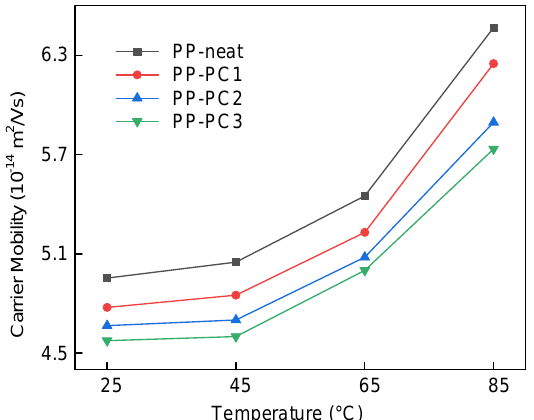
Figure 7. Relationship between the carrier mobility and the sample temperature. It also can be obtained that the carrier mobility of PP-PC1, PP-PC2, and PP-PC3 is lower than that of PP-neat. The decreased carrier mobility can be explained by the introduced DTLs by polycyclic compounds. It is hard for trapped charges to detrap from DTLs because the trapped charges need more energy to detrap from the DTLs. The PP-PC3 presents the lowest carrier mobility, which is related to the deepest DTLs of PP-PC3. The decreased carrier mobility leads to the lower DC conductivity of PP-PC1, PP-PC2, and PP- PC3, as shown in Figure 3. The lowest carrier mobility explains the mechanism of the lowest DC conductivity of PP-PC3 at different temperatures.